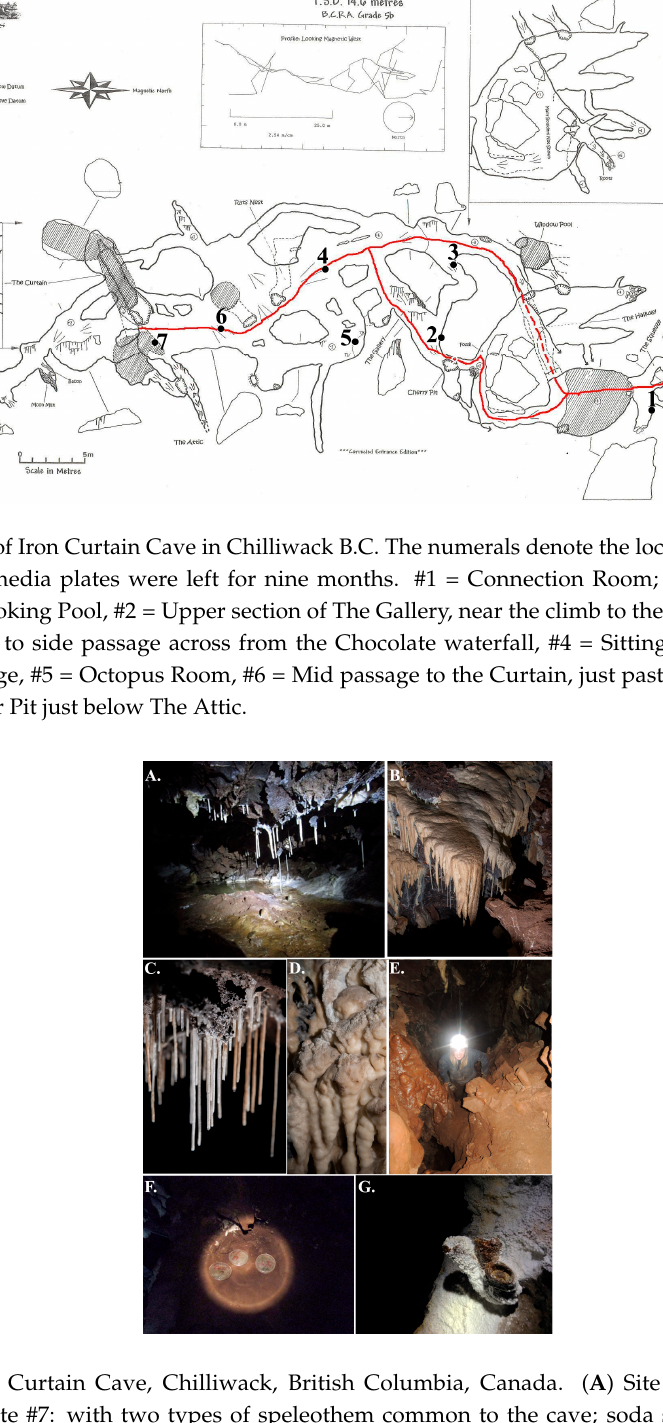
Figure 2. Iron Curtain Cave, Chilliwack, British Columbia, Canada. ( A ) Site #4: The Octopus Room; ( B , C ) Site #7: with two types of speleothem common to the cave; soda straws and